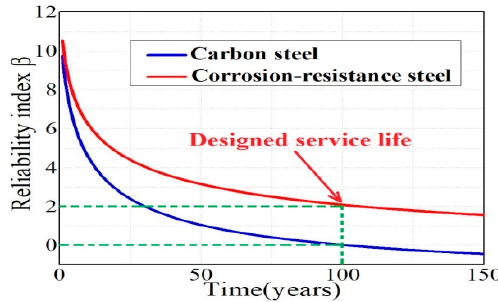
Figure 16. Reliability index calculated by the Monte-Carlo simulation for the pier concrete.